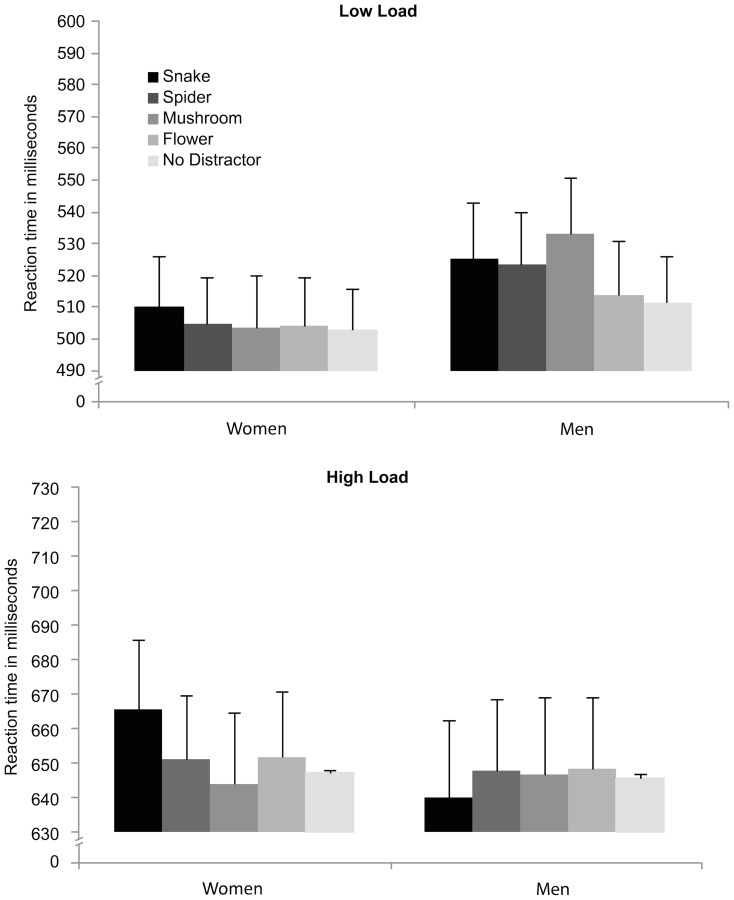
Experiment 4: Mean Reaction Times (RTs) in milliseconds (ms) to discriminate the target letter (X or N) in the different type of distractor conditions (snake, spider, mushroom, flower, and no distractor), as a function of the perceptual load condition (low; high) and the sex of the participant (women; men).Longer RTs indicate larger interference scores.